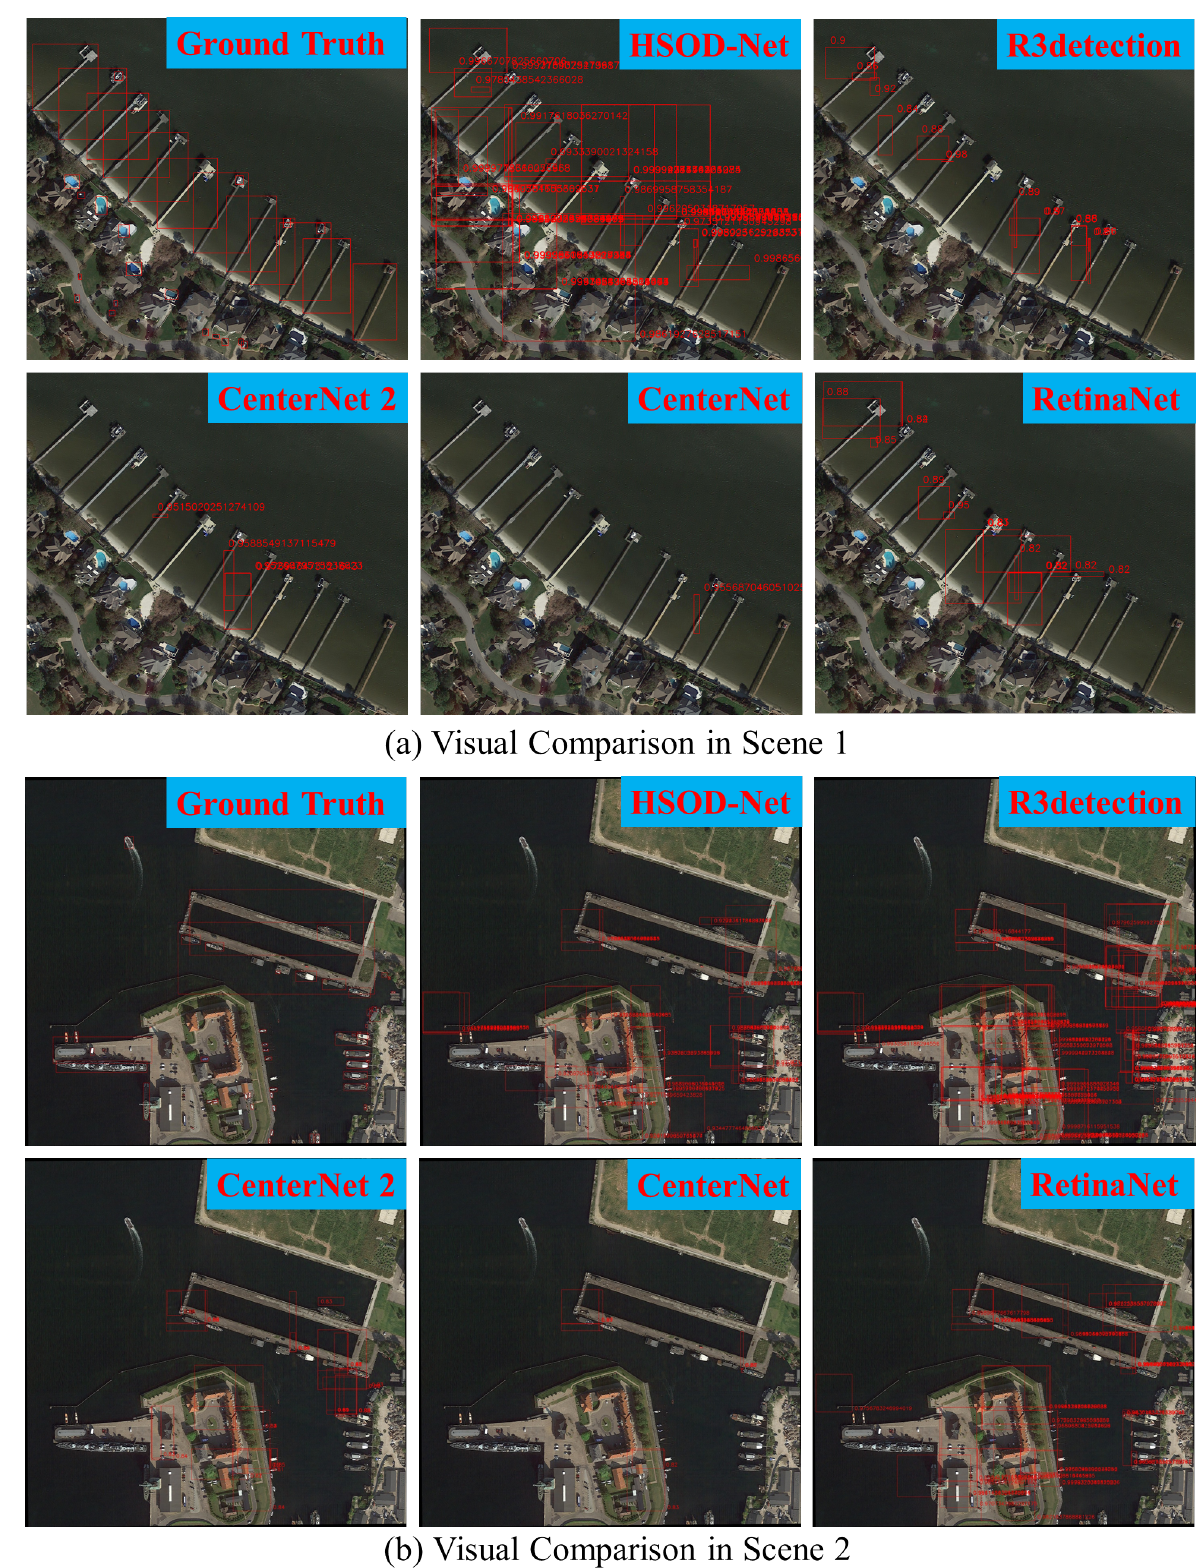
Figure 7. Visual comparison of different detection methods for two randomly selected image from the DOTA validation